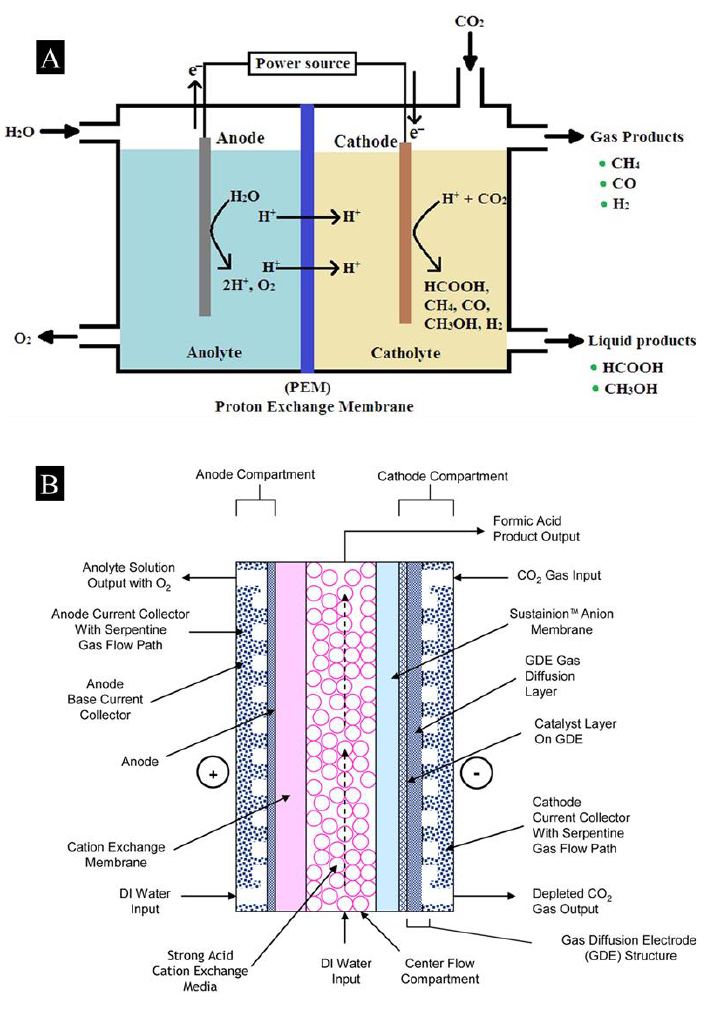
Figure 1. ( A ) Basic configuration of electrochemical reduction of CO 2 conversion consisting of cathode and anode through which electricity is applied in the electrolytic solution [27]. Reproduced with permission from Elsevier 2021. ( B ) Electrochemical conversion of CO 2 to formic acid facilitated by the presence of imidazolium ionomer in the nanoparticle Sn catalyst at GDE cathode [18]. Reproduced with permission from Elsevier 2017.